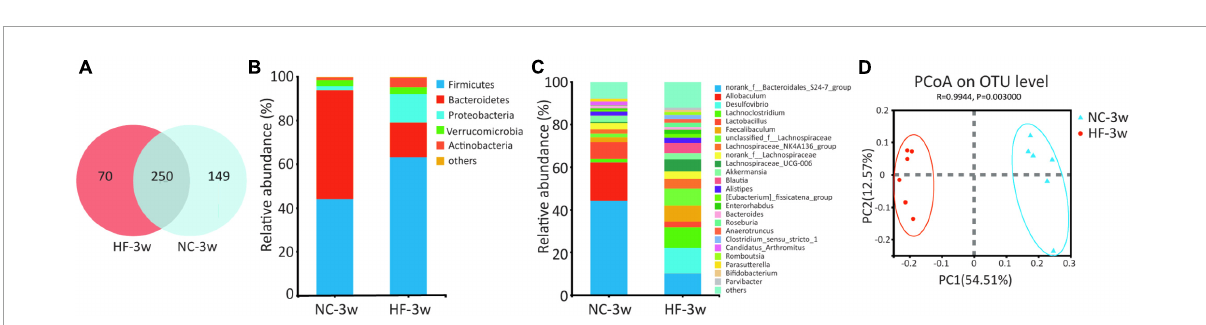
FIGURE2 Maternal HF feeding altered structures and composition of gut microbiota in offspring at weaning. (A) Venn diagram of the OUTs. (B) Relative abundance of the bacterial population at the phylum level. (C) Relative abundance of the bacterial population at the genus level. (D) PCoA plots of gut communities (NC-3w, n = 6; HF-3w, n = 6). NC, normal chow diet; HF, high-fat diet. OTUs, operational taxonomic units; PCoA, principal coordinate